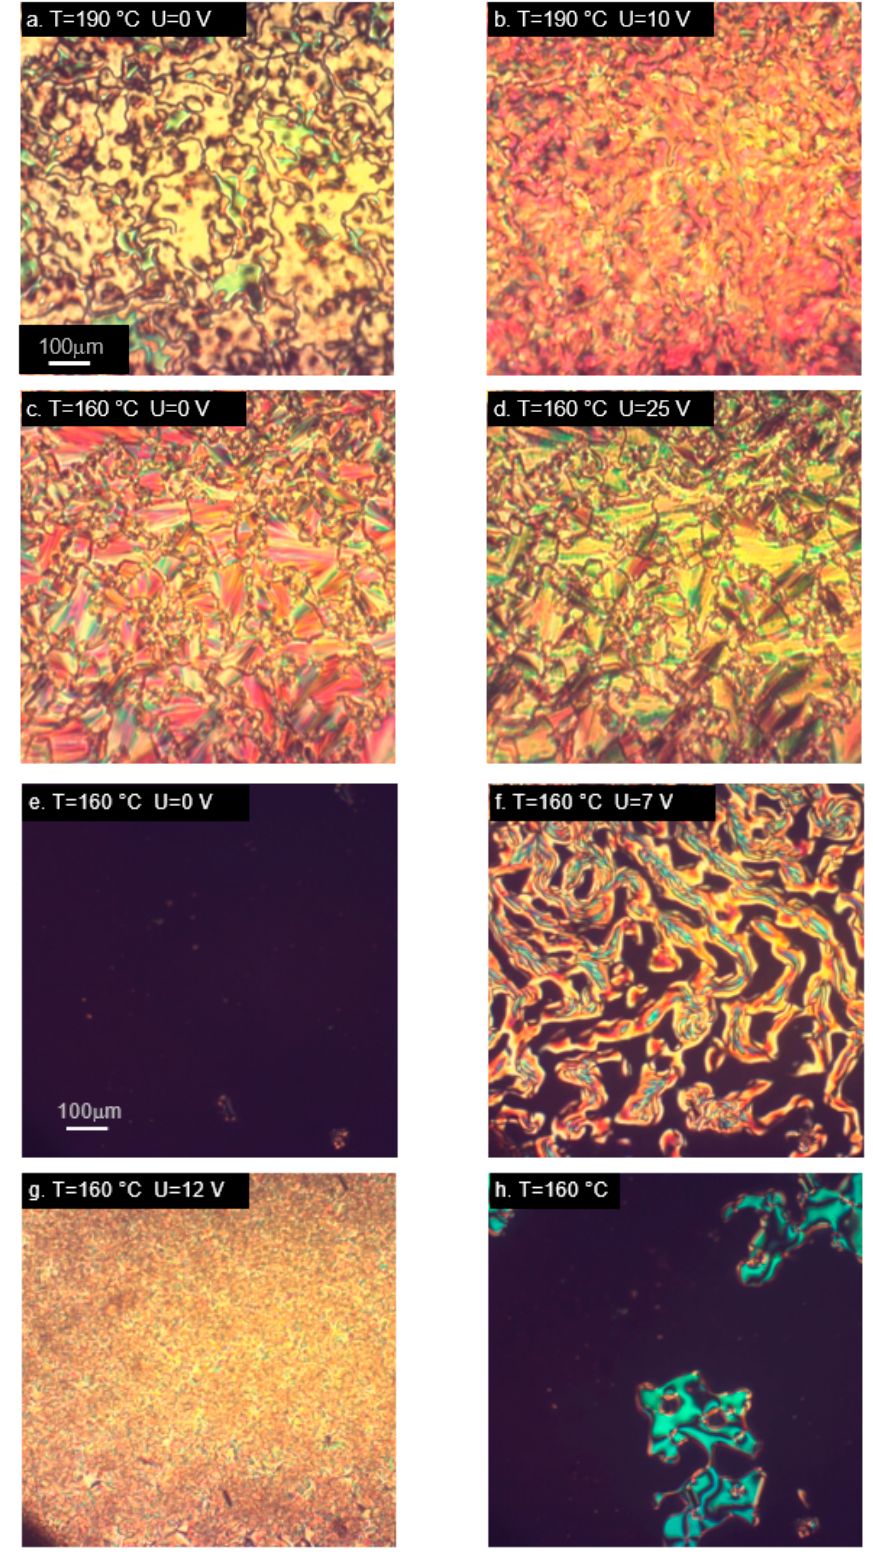
Figure 5. Microphotographs (in cross-polarized light) of tri-aromatic compounds M22 ( a – d ) and MU22 ( e – h ) in nematic ( a , b , e – h ) and smectic phase ( c , d ), showing alignment changes due to electric field. Samples placed in cells with layers inducing homeotropic orientation. ( h ) Vanishing of alignment after switching off the electric field.